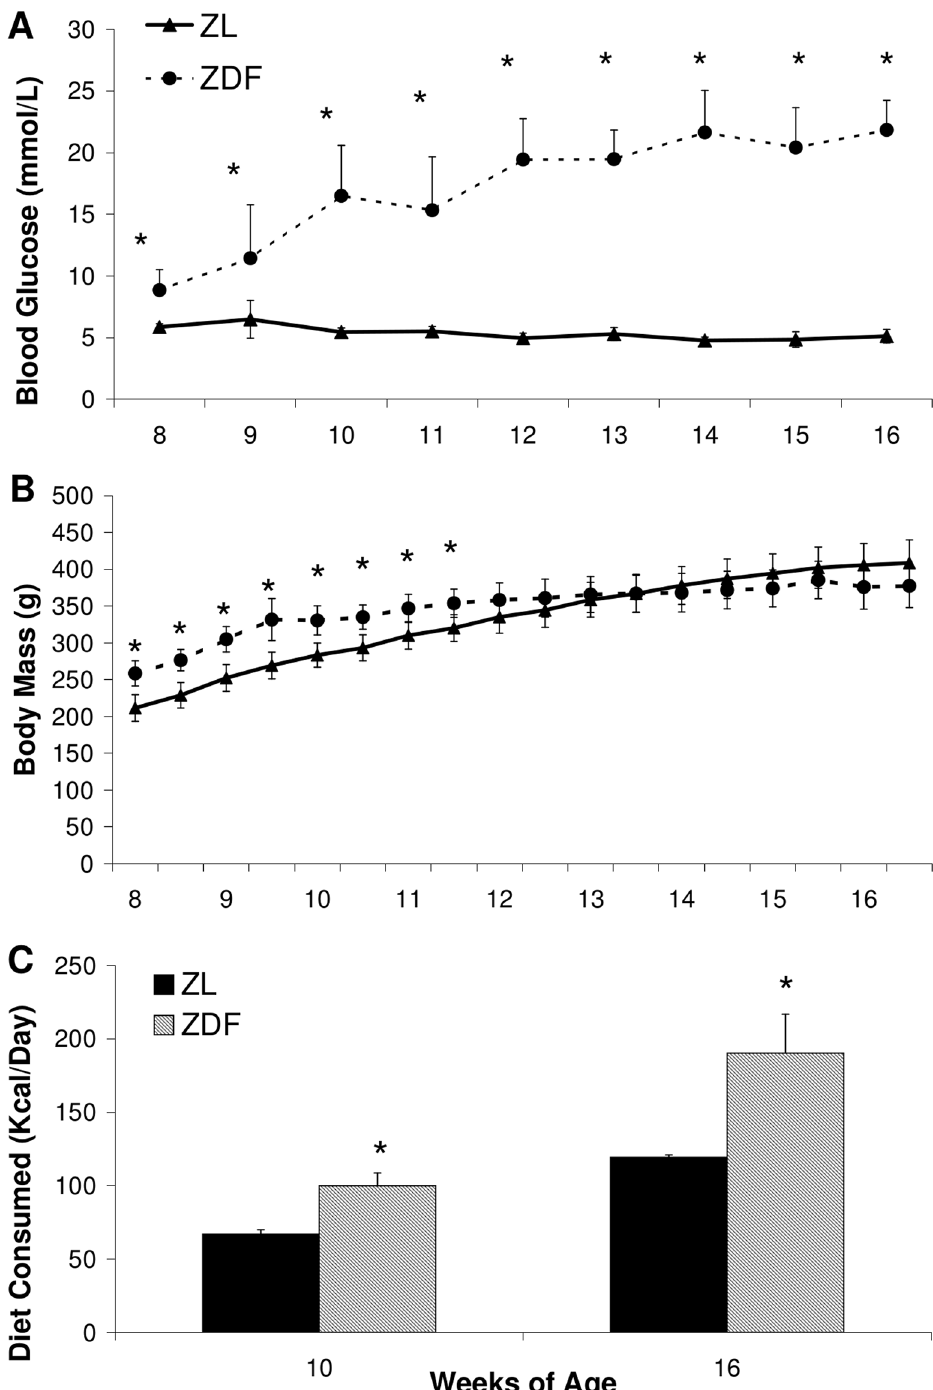
Fig 1. Animal model characteristics of ZDF and ZL animals. Blood glucose (A), body mass (B), and diet consumed (C). Data are mean ± SD. n = 7 – 10 per group. * p < 0.05 vs ZL, Students t-test.